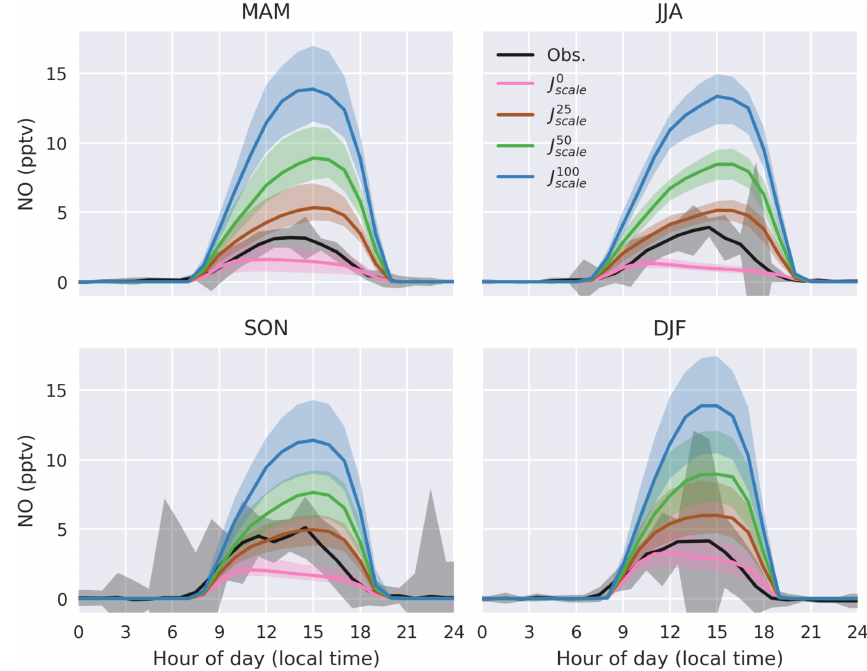
Figure 3. Observed and modeled diurnal cycles of NO at CVAO during different seasons (MAM: March, April, May; JJA: June, July, August; SON: September, October, November; DJF: December, January, February) in 2014–2015. Solid lines represent median values, and shaded regions show first and third quartiles of model values and standard error of observations. Model simulations assume a HONO : NO 2 molar yield of 0 . 67 : 0 . 33 from NITs